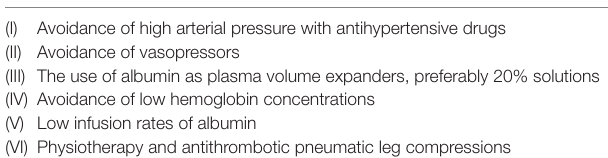
TABLe 2 | Potential measures adopted in the Lund concept to reduce transcapillary leak and the need of albumin (and crystalloids) as plasma volume